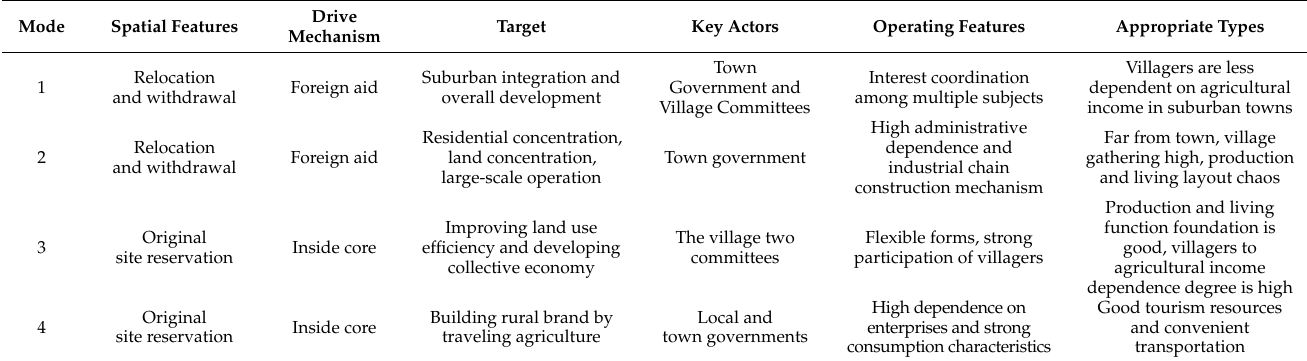
Table 3. Applicable conditions of different hollow village governance